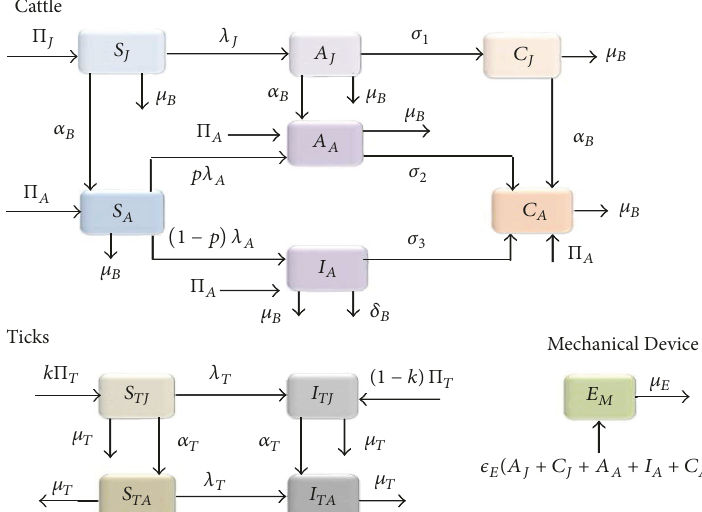
Figure 1: Flow diagram of the juvenile and adult cattle bovine anaplasmosis model (12). The cattle population is divided into susceptible ( 𝑆 𝑖 ), asymptomatic infectious ( 𝐴 𝑖 ), symptomatic infectious ( 𝐼 𝐴 ), and carrier ( 𝐶 𝑖 ) compartments, where 𝑖 = 𝐽, 𝐴 for juvenile and adult subpopulations, respectively. The tick population consists of susceptible ( 𝑆 𝑇𝑖 ) and infectious ( 𝐼 𝑇𝑖 ) classes, where 𝑖 = 𝐽,𝐴 for nymph and larvae classes, respectively. Colors blue, purple, and orange represent susceptible, infectious, and infectious asymptomatic and carrier cattle, respectively. For ticks, tan and grey represent susceptible and infected ticks. The brighter shade represents juveniles (cattle or ticks); darker shade represents adults (cattle or ticks). The mechanical device is represented by